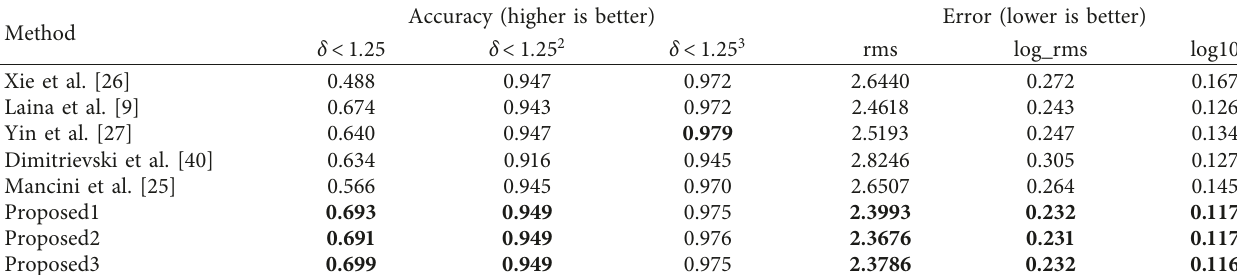
Table 1: Depth estimation results on the KITTI data